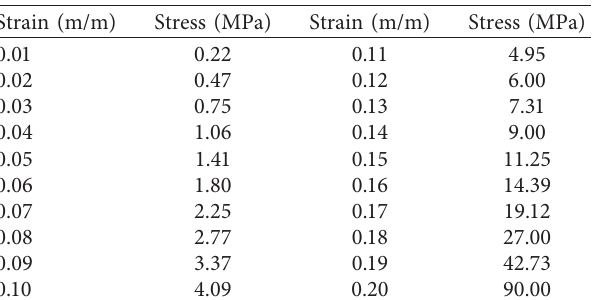
Table 2: Cap pressures for the double-yield model.